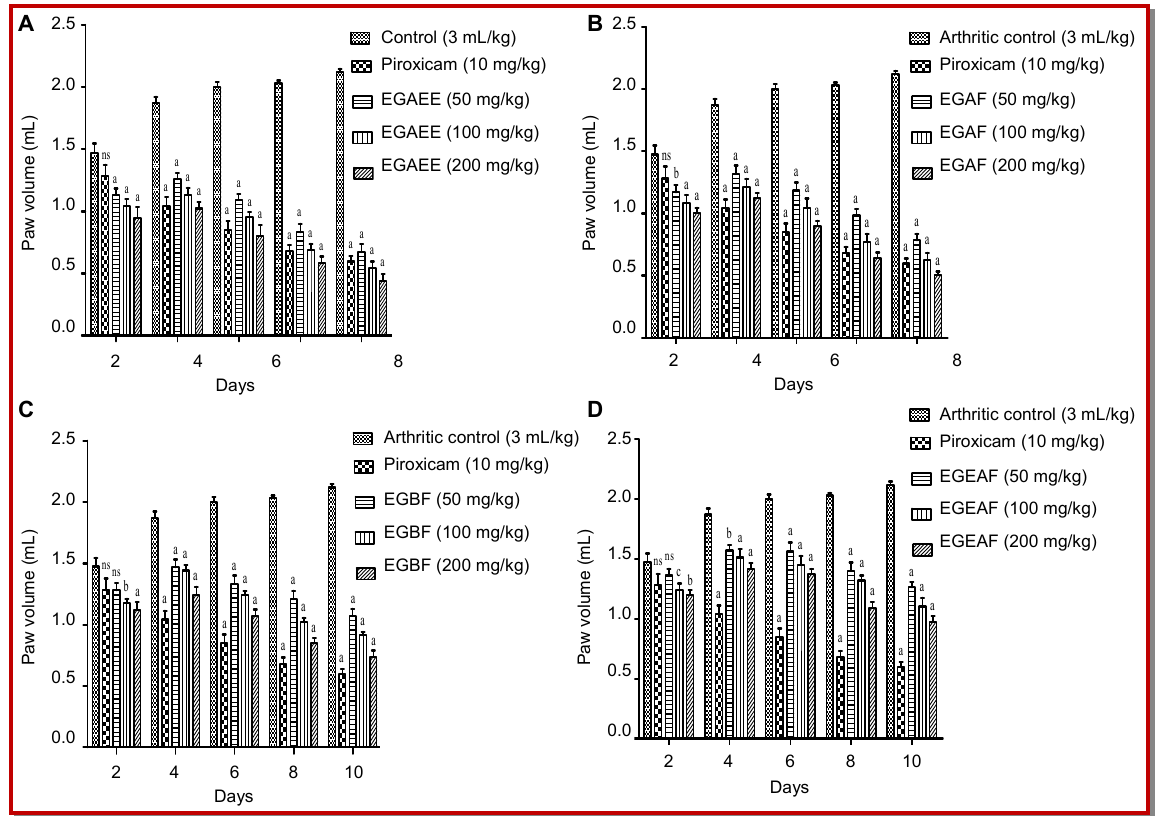
Figure 4: Effect of E. gerardiana extract and fractions: (A) Aqueous ethanolic extract, (B) Aqueous fraction, (C) n- butanol fraction, (D) Ethyl acetate fraction) on paw volume of formaldehyde induced arthritic rats. a p<0.001, b p<0.01, c p<0.05, ns non-significant when compared to arthritic control. EGAEE= E. gerardiana aqueous ethanolic extract, EGAF= E. gerardiana aqueous fraction, EGBF= E. gerardiana butanol fraction, EGEAF= E. gerardiana ethyl acetate